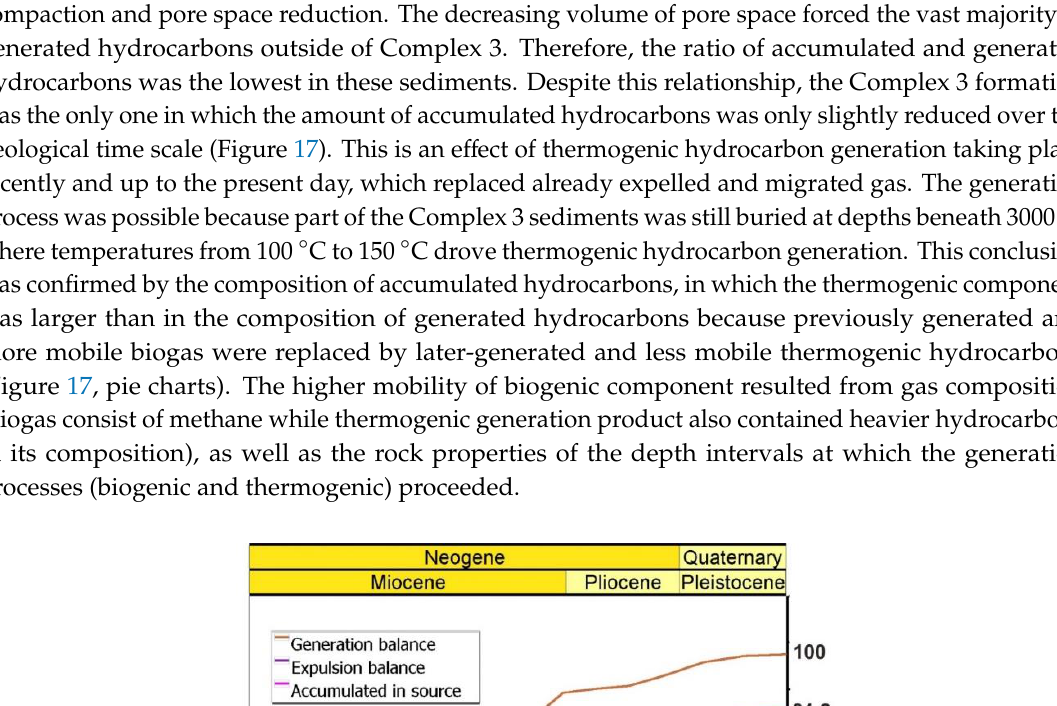
the generated and accumulated gas quantities became comparable (Figure